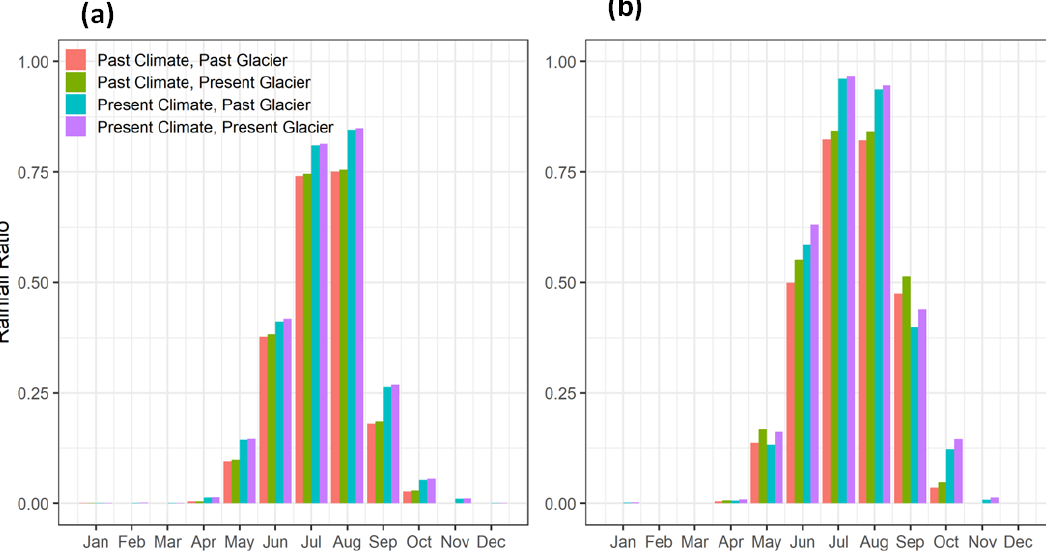
Figure 4. Mean monthly rainfall ratios simulated for the four model run scenarios, with A–D combining the past and present climate and glacier. (a) AGRB. (b)